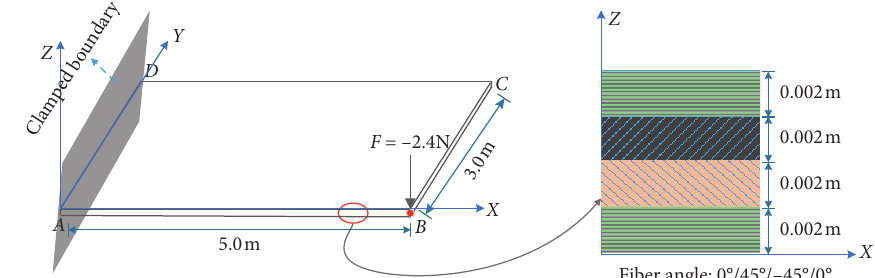
Figure 8: A cantilever composite laminated shell subjected to a vertical force.